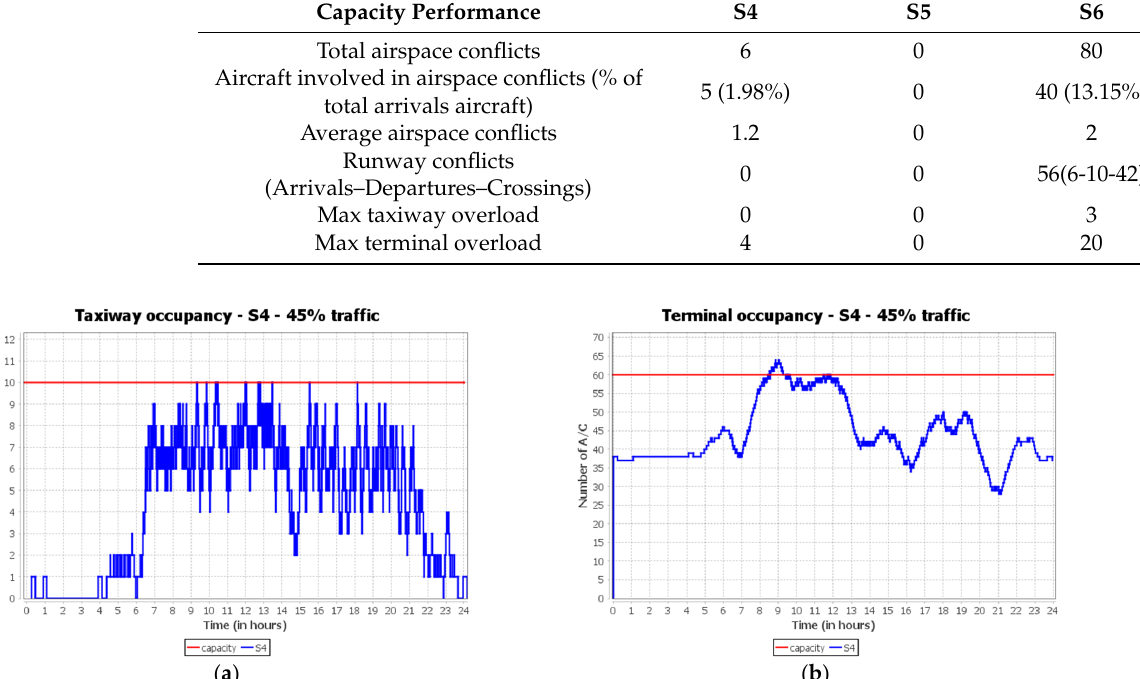
Figure 10. Taxiway ( a ) and terminal ( b ) occupancy scenario S4.